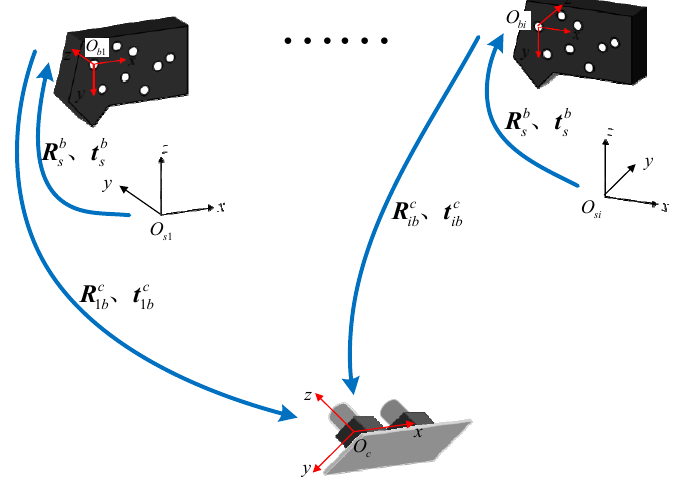
Figure 7. Coordinate systems during calibration.